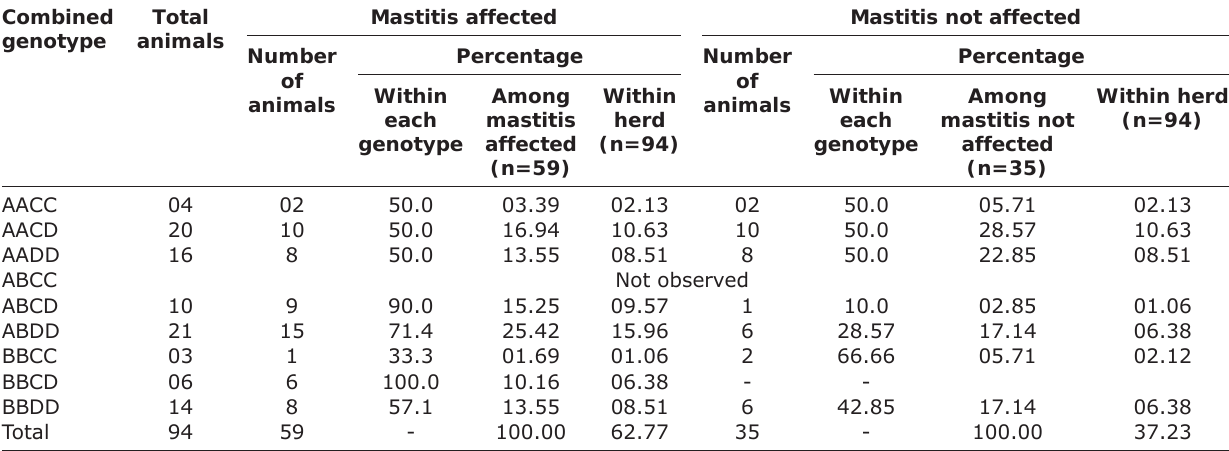
Table-5: Frequency of combined genotype of CD14 gene in KF cattle. Combined Total Mastitis affected Mastitis not genotype animals